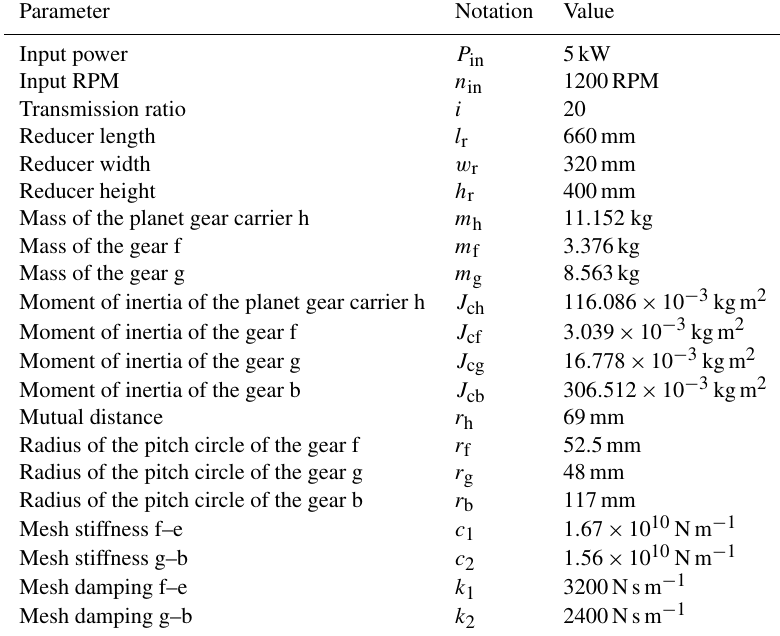
Table 1. Basic parameters of the dynamical model.